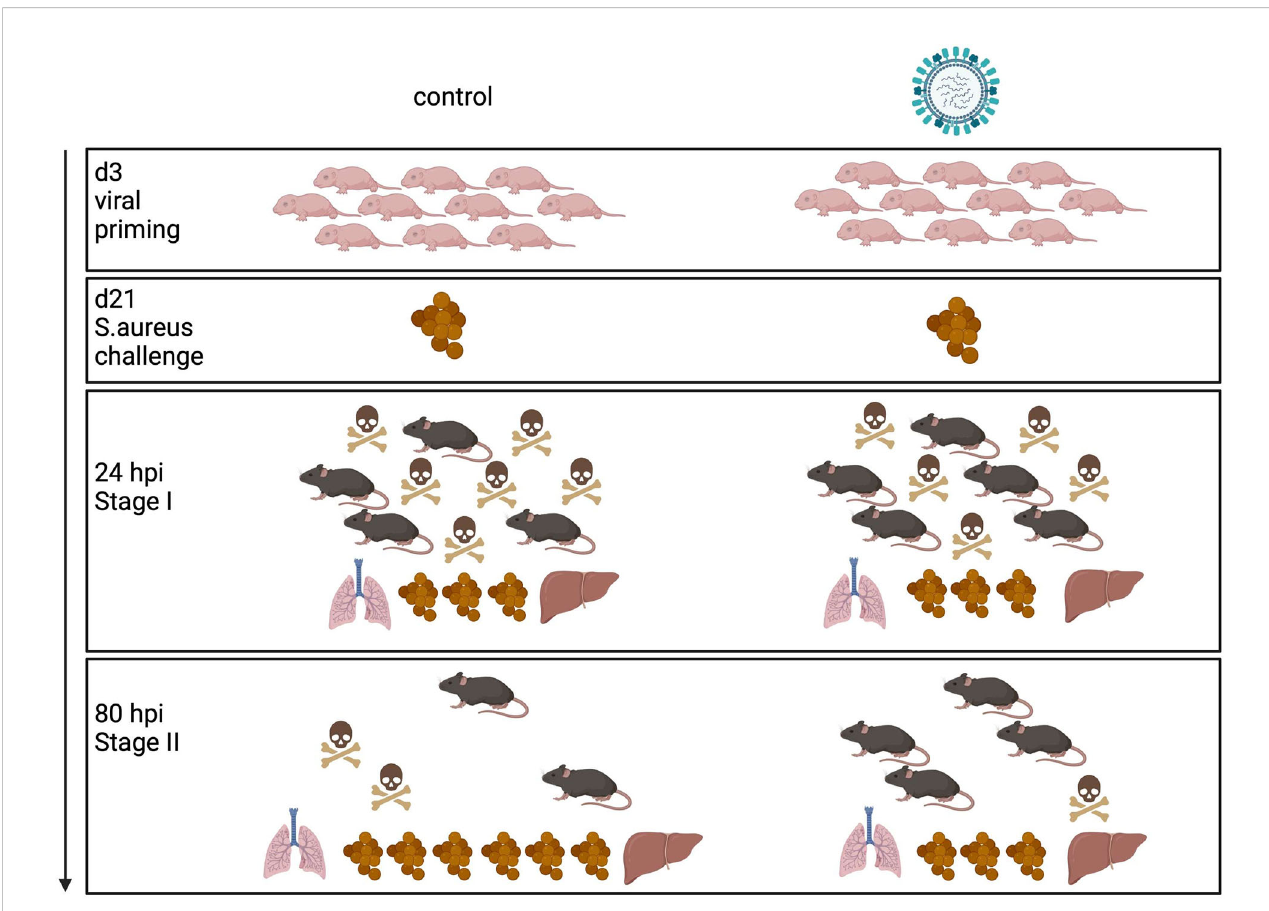
FIGURE 7 Model of innate antimicrobial priming by IAV exposure early in life. Graphical summary how a respiratory exposure of murine d3 neonates to IAV shapes their antimicrobial immunity in the long-term. While an early-life encounter of IAV does not in fl uence the performance of the antimicrobial response during the acute early stage of a systemic S. aureus infection in adolescence (stage I), it improves pathogen clearance and survival during the second stage of sepsis (stage II). Control mice are depicted on the left side, mice challenged with IAV on d3 on the right side. The numbers of mouse icons are an approximation based on our experimental fi ndings. Created with